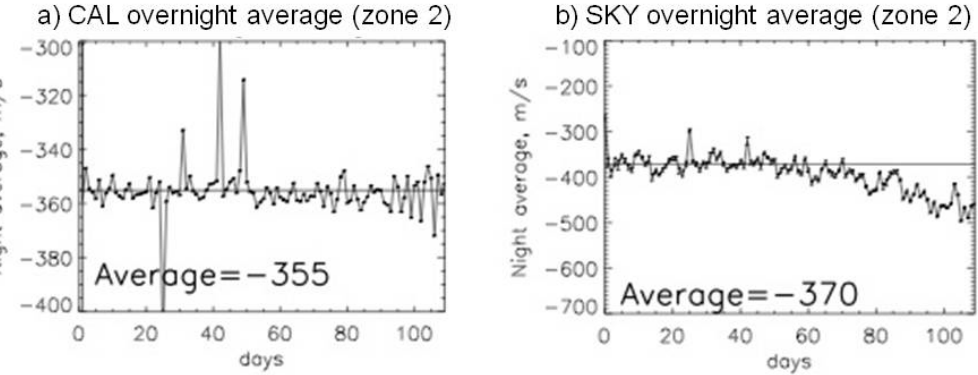
Fig. 6. Variation of the (a) calibration lamp peaks (CAL), and (b) 630nm emission peaks (SKY) throughout the winter of 2007–2008 for zone